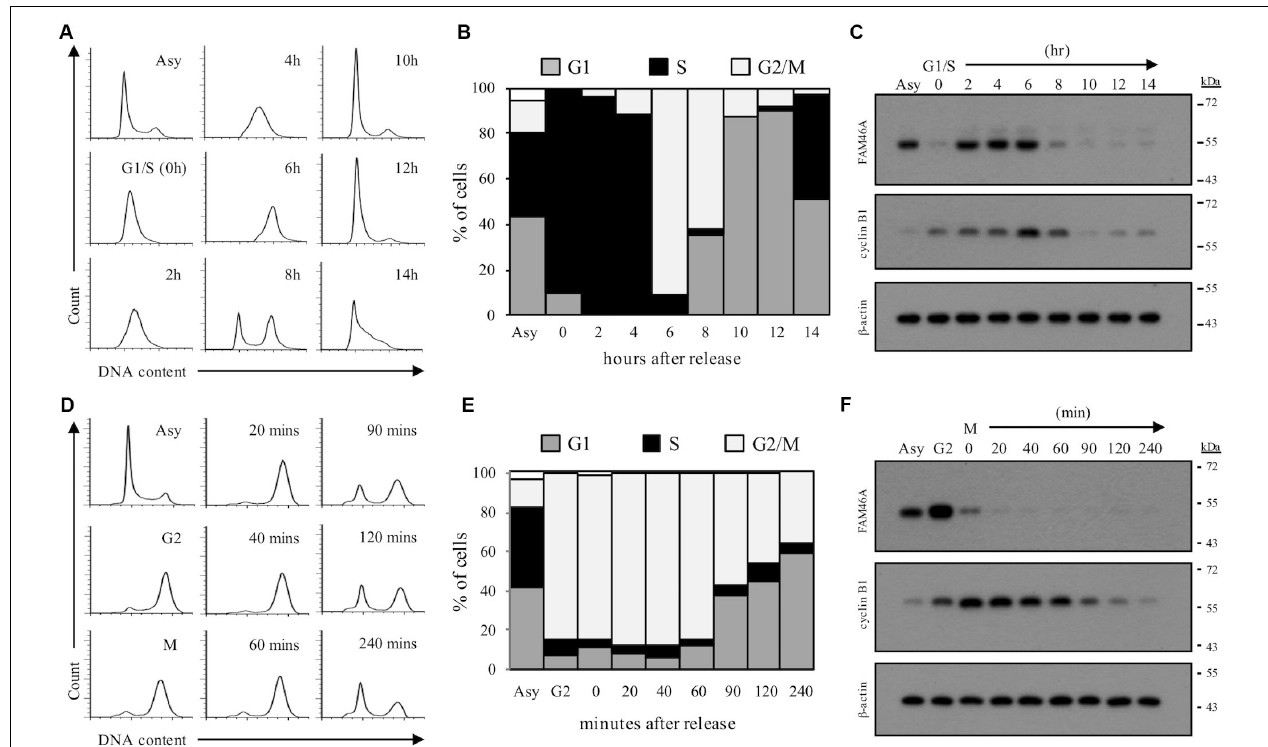
FIGURE 5 | Cell cycle-regulated expression of FAM46A protein. FAM46A-myc transfected HeLa cells were synchronized at the G1/S boundary by double thymidine block (A–C) or at the G2/M boundary by thymidine-nocodazole block (D–F) , and released at various time points as indicated. Cell cycle progression was monitored by the FACS analysis of cellular DNA contents (A,D) . The profiles of synchronous peaks were fitted with Dean-Jett-Fox model using FlowJo software. Percentage of cells in the G1, S, and G2/M phases was presented (B,E) . Changes in protein levels of FAM46A and cyclin B1 during cell cycle progression were revealed using Western blot analysis (C,F) . Equal amounts (30 µ g) of whole cell lysates collected from synchronized cells were loaded in each lane. Expression of β -actin was included as a control. Data shown were representatives of three independent